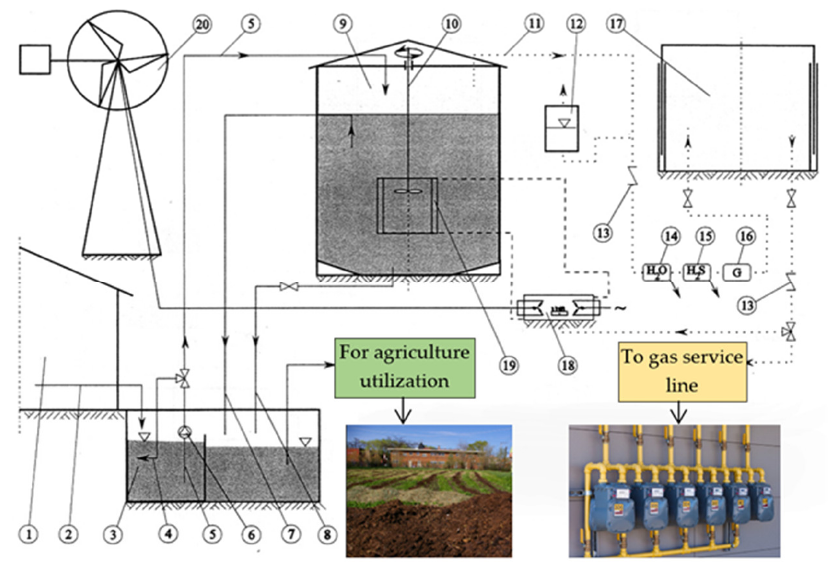
Figure 2. Scheme of biogas installation with fermentation chamber. 1 —Livestock building, 2 —direct supply pipeline of liquid manure from building, 3 –preliminary container, 4 —mixing pipeline, 5 —supply